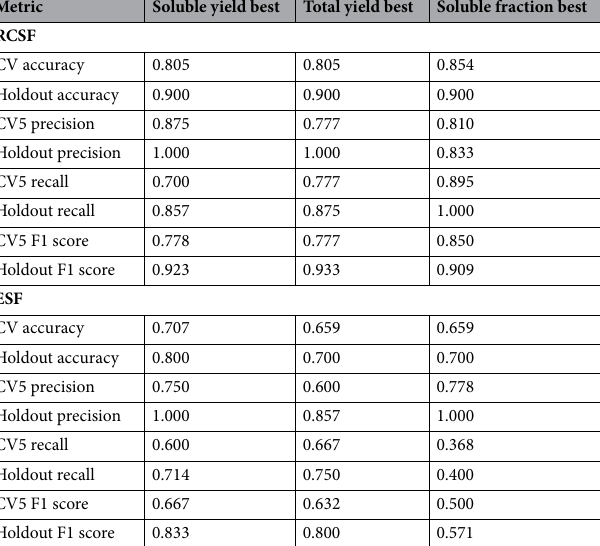
Table 5. Classification metrics of classifiers. CV5 corresponds to Stratified fivefold cross